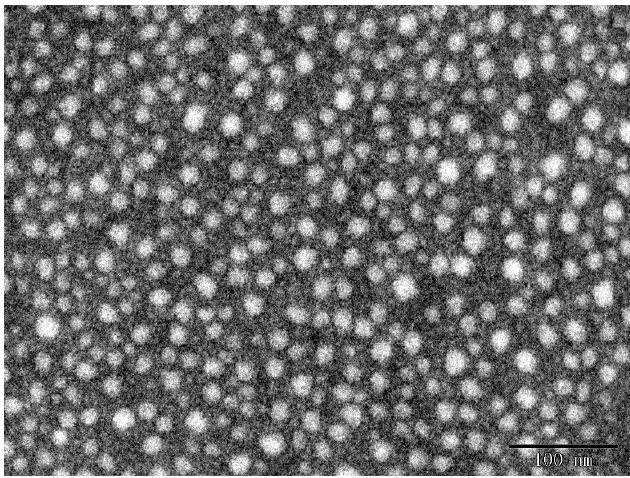
Figure 3. Transmission electron microscopy (TEM) images of GP-GED-TA particles. The scale bar is 100 nm.